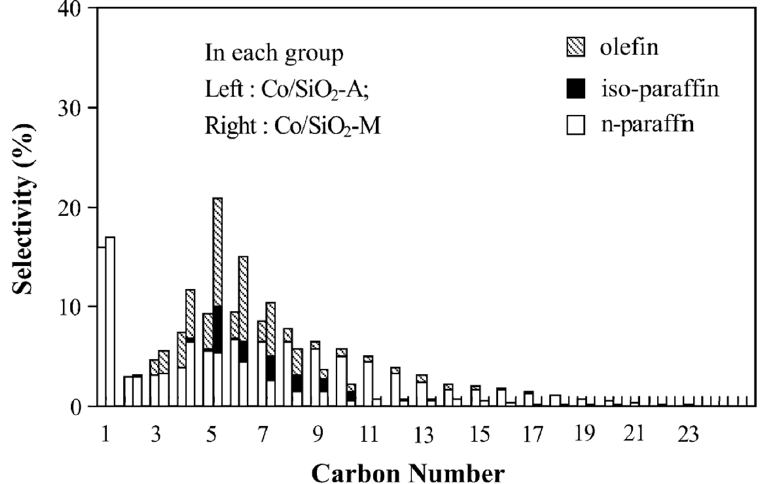
Figure 8. Product distribution of FTS reaction on the zeolite capsule catalysts. Reprinted with permission from [74]. Copyright (2007) Elsevier Science BV, Amsterdam, The Netherlands.